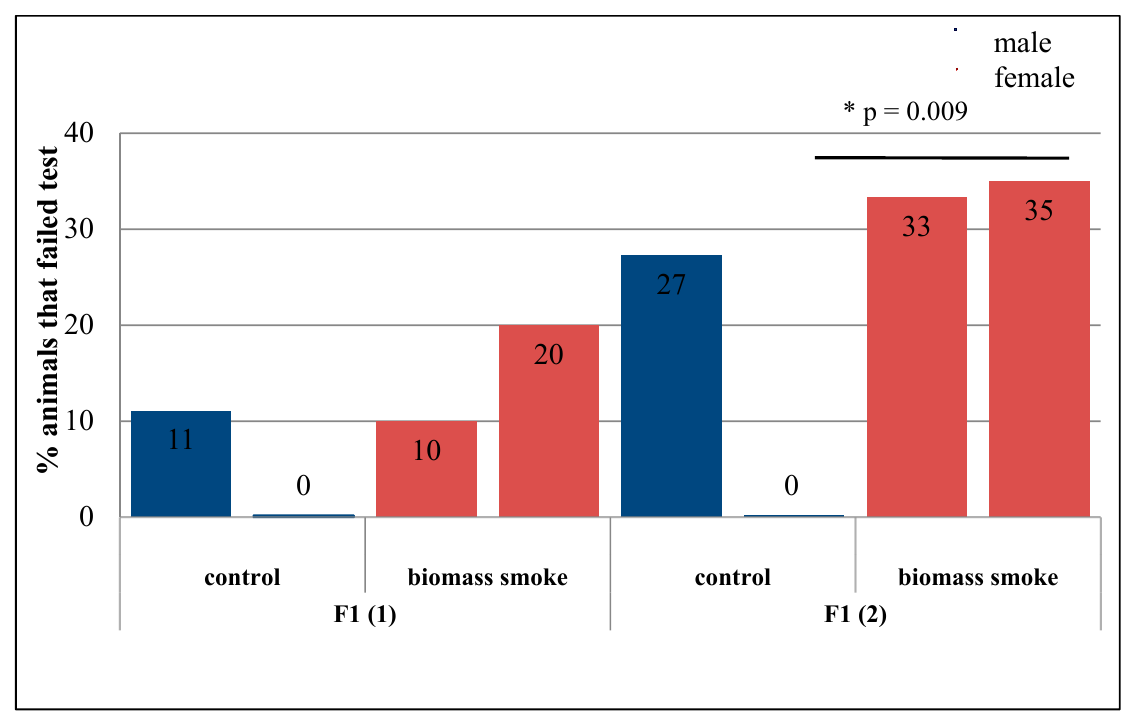
Figure 6. Test results in the Morris water maze. Number of animals that completed and failed the test. Note: * the differences statistically significant compared to the control at p < 0.05.